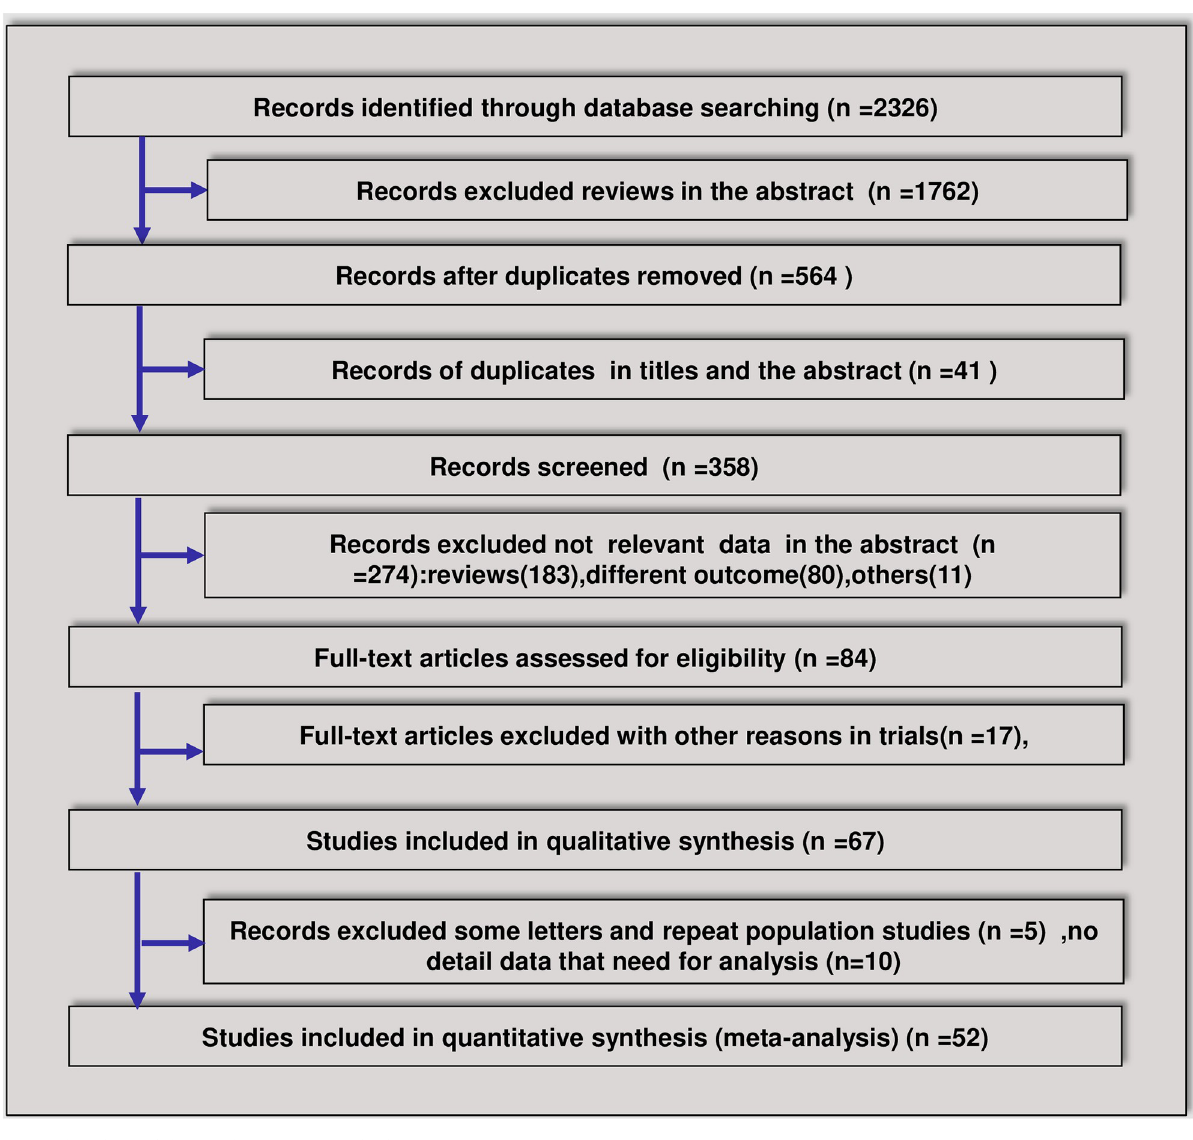
Fig 1. Flowchart of the article screening and selection